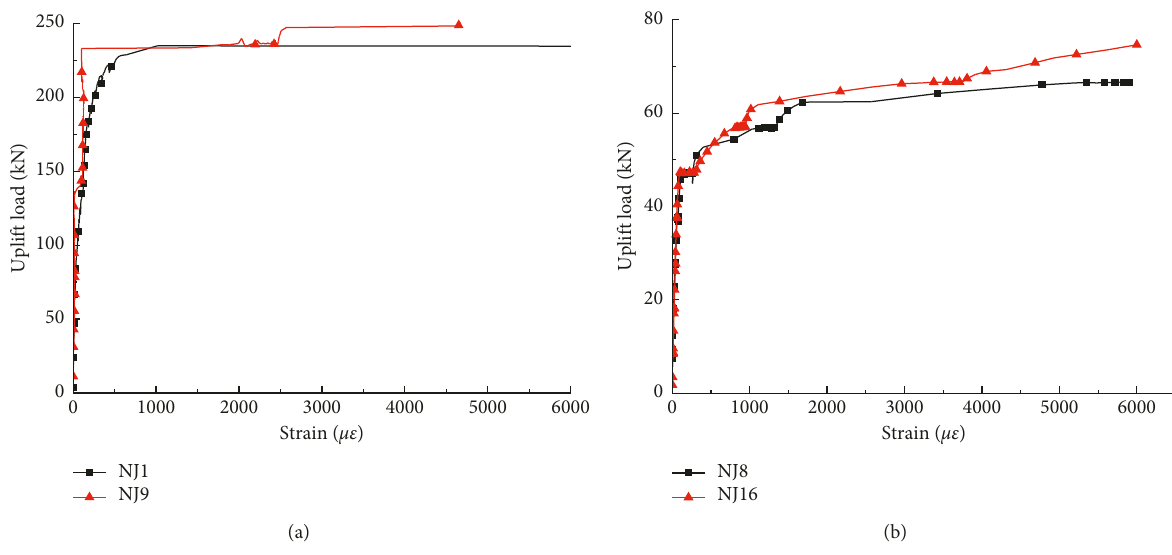
Figure 7: Typical load-strain curve for the test specimens. (a) NJ1(NJ9). (b) NJ8(NJ16).